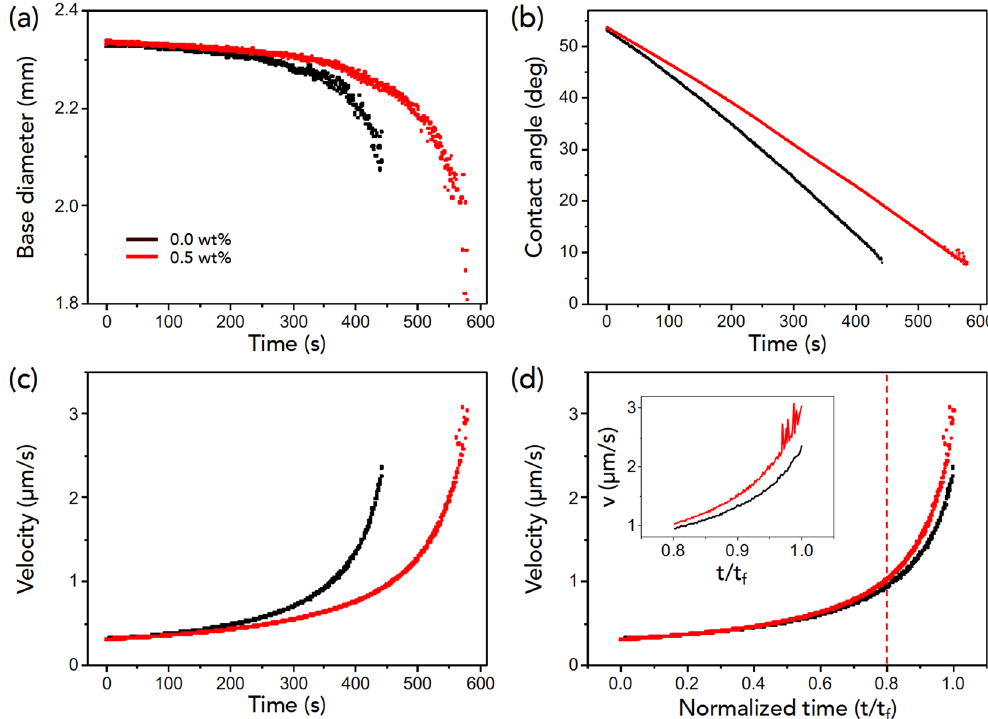
Figure 4. Hydrodynamics of droplet evaporation with large colloids. ( a , b ) Time evolution of the base diameter and of the contact angle taken for suspension droplets of large (10- μ m-diameter) colloids without and with polymers. The complete drying time of the droplet with large colloids is slower with polymers than without polymers: therefore, the base diameter and the contact angle more slowly decrease with time with polymers than without polymers. ( c , d ) Time evolution of estimated height-averaged radial velocity, taken from ref. 36 and data in ( a , b ). Here ( d ) is rescaled from ( c ) with the normalized time t / t f for comparison. Inset indicates the velocity details after 0.8 t f